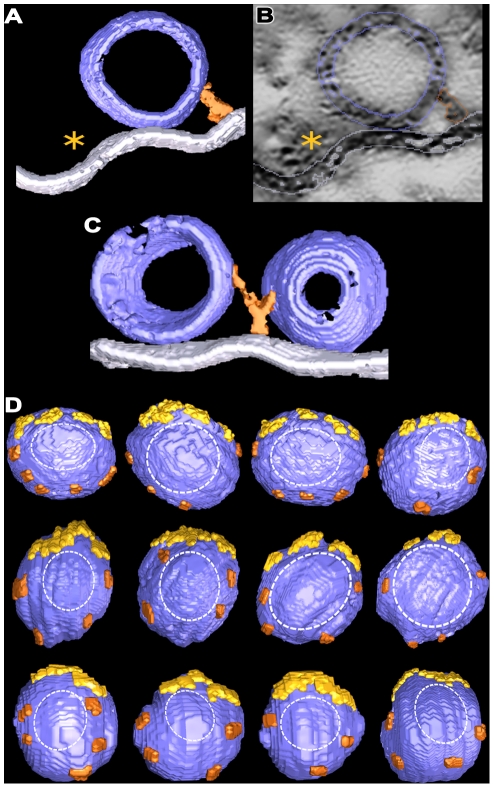
Arrangement of pins at resting active zones.A) A surface model, 9 nm thick, from an active zone sectioned in the transverse plane. A pin (copper) links the hemisphere of a docked vesicle that faces away from the active zone ridge (asterisk) to the presynaptic membrane. B) A virtual slice, 0.5 nm thick, from the series of virtual slices segmented to generate the surface model in A. The pin, docked vesicle and presynaptic membrane are outlined. An asterisk marks the main body of the AZM in the active zone ridge. C) A surface model, 20 nm thick, from an active zone sectioned in the median plane. The docked vesicles are from a row of such vesicles flanking the main body of AZM. A pin between the vesicles bifurcates to link the vesicles to the presynaptic membrane. D) The connection sites of pins and ribs (marked by ∼3 nm long segments of each: ribs, yellow gold; pins, copper) on docked synaptic vesicles viewed in the horizontal plane. The vesicles are from four active zones that were sectioned in the median or transverse planes after fixation by glutaraldehyde or rapid freezing. The connection sites surround the region of contact between the vesicle membrane and presynaptic membrane (dashed outline).